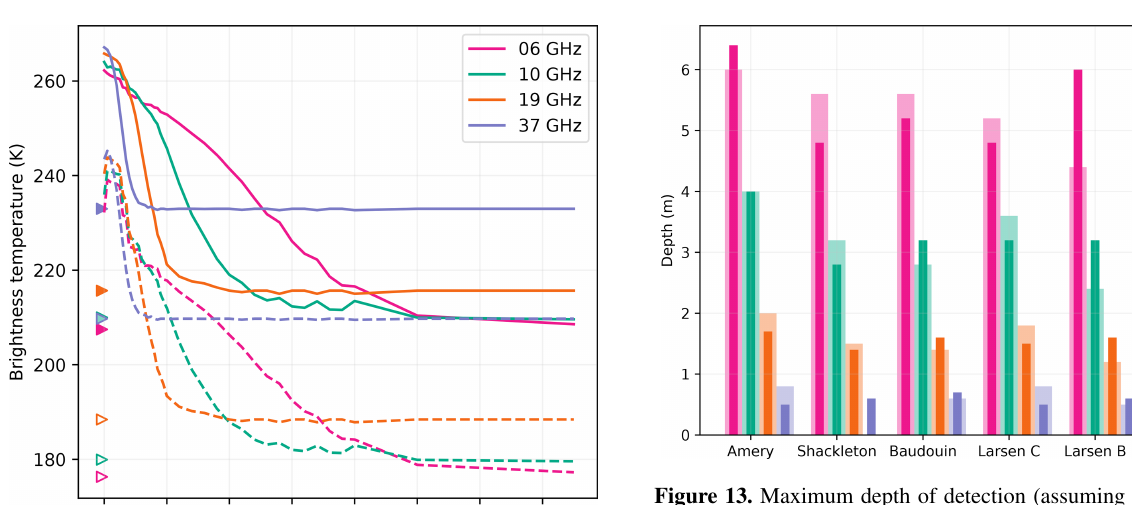
Figure 13. Maximum depth of detection (assuming a threshold at dry brightness temperature + 20K) as a function of season, site and frequency. The polarization is horizontal. Winter and autumn are in light- and dark-color shades respectively. Melt in Maudheimvida and Halvfarryggen is never detected with the aforementioned crite-